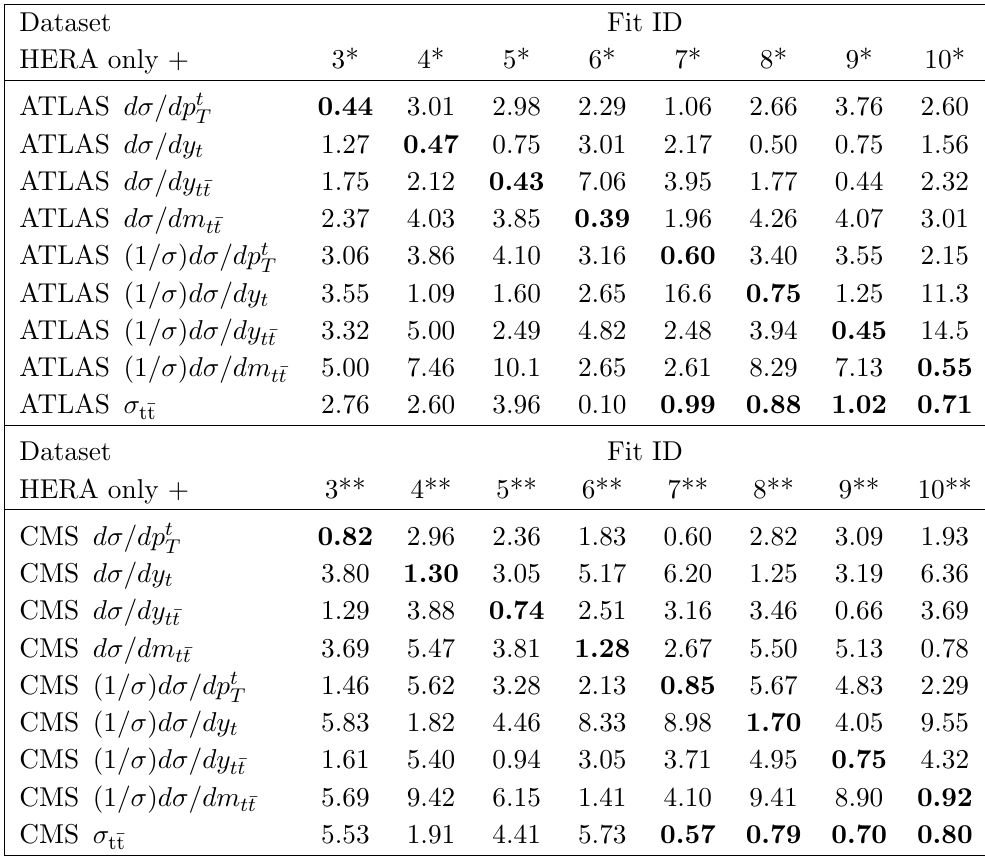
Table 8 . Same as table 6 for the (cid:12)ts where the ATLAS and CMS data are included separately.